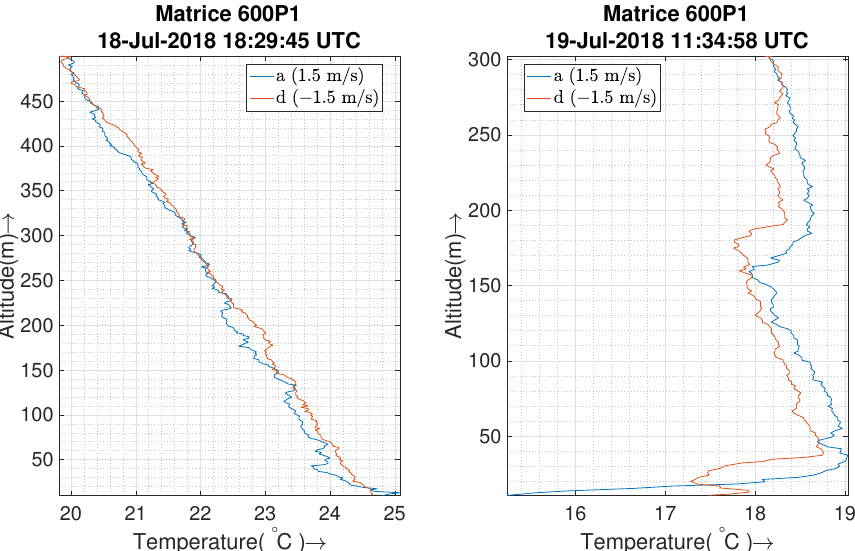
Figure 14. The first subplot shows unfiltered temperature data collected from 10 m–500 m of a well-mixed atmosphere at noon with a ground wind of 1.6m/s with a 5m/s